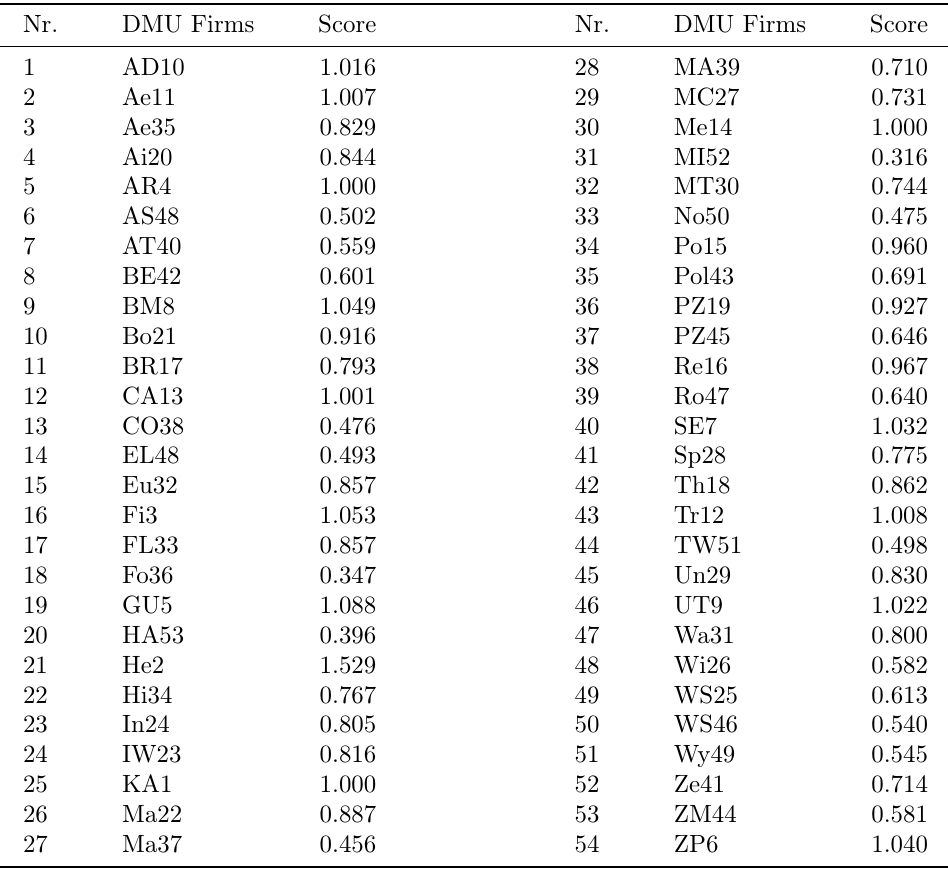
Table 6: SBM-SE scores of 55 firms in the Aviation Cluster in Podkarpackie in Poland